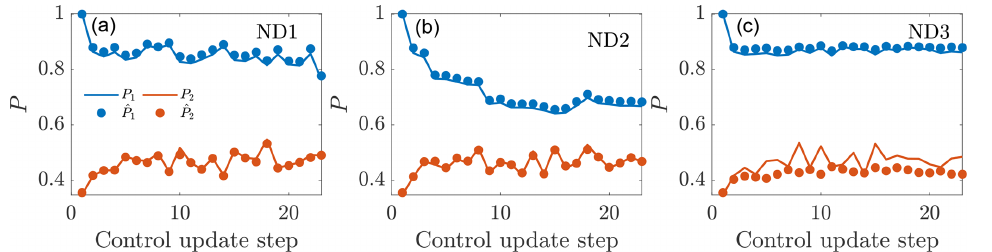
Figure 16. Time-averaged power production for the first and second wind turbines in the wind farm as a function of the control update steps for (a) online control using the initial parameters to initialize the next state (ND1), (b) online control using the previous optimal parameters to initialize the next state (ND2), and (c) the static state estimation control (ND3). The LES power production is given by P , and the wake model state estimation is given by ˆ P .